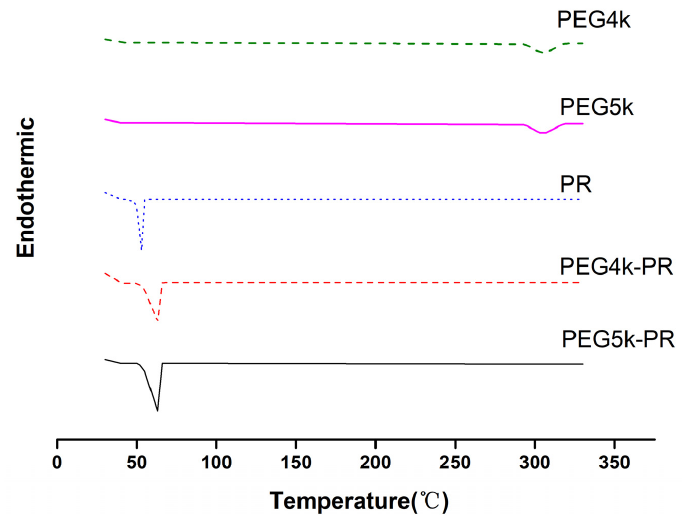
Figure 5. Di ff erential scanning calorimetry (DSC) data of PR, PEG4k / 5k, and PEG4k / 5k-PR. Figure 5. Differential scanning calorimetry (DSC) data of PR, PEG4k/5k, and PEG4k/5k-PR.